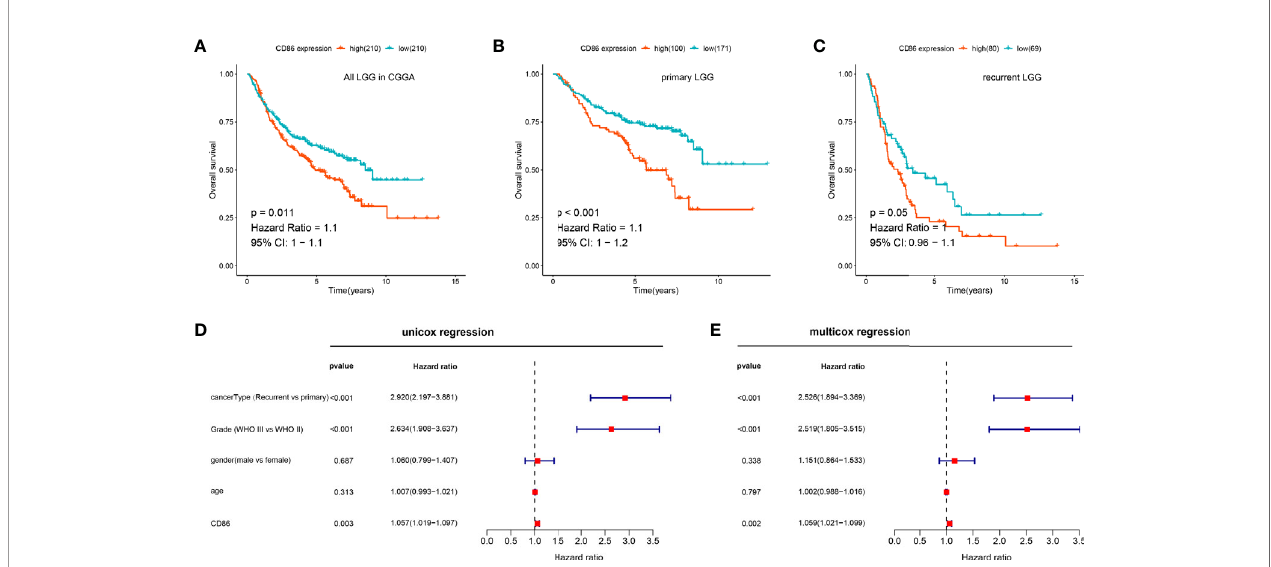
FIGURE 6 | Validation of the prognostic value of CD86 for LGG in CGGA. (A) Kaplan-Meier analysis of CD86 expression and OS in all LGG. (B) Kaplan-Meier analysis of CD86 expression and OS in primary LGG. (C) Kaplan-Meier analysis of CD86 expression and OS in recurrent LGG. (D) Univariate Cox regression of CD86 expression, LGG cancer type (primary or recurrent), grade, gender and age. (E) Multivariate Cox regression using the same